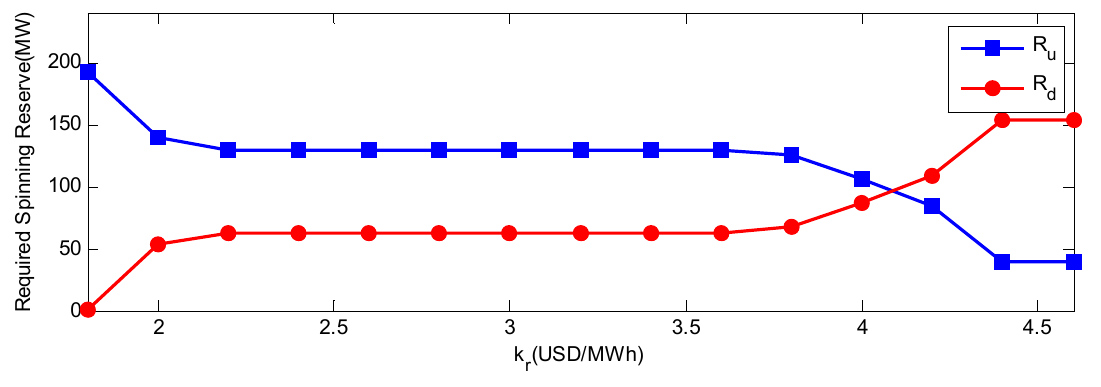
Figure 7. The required spinning reserve as a function of up reserve cost